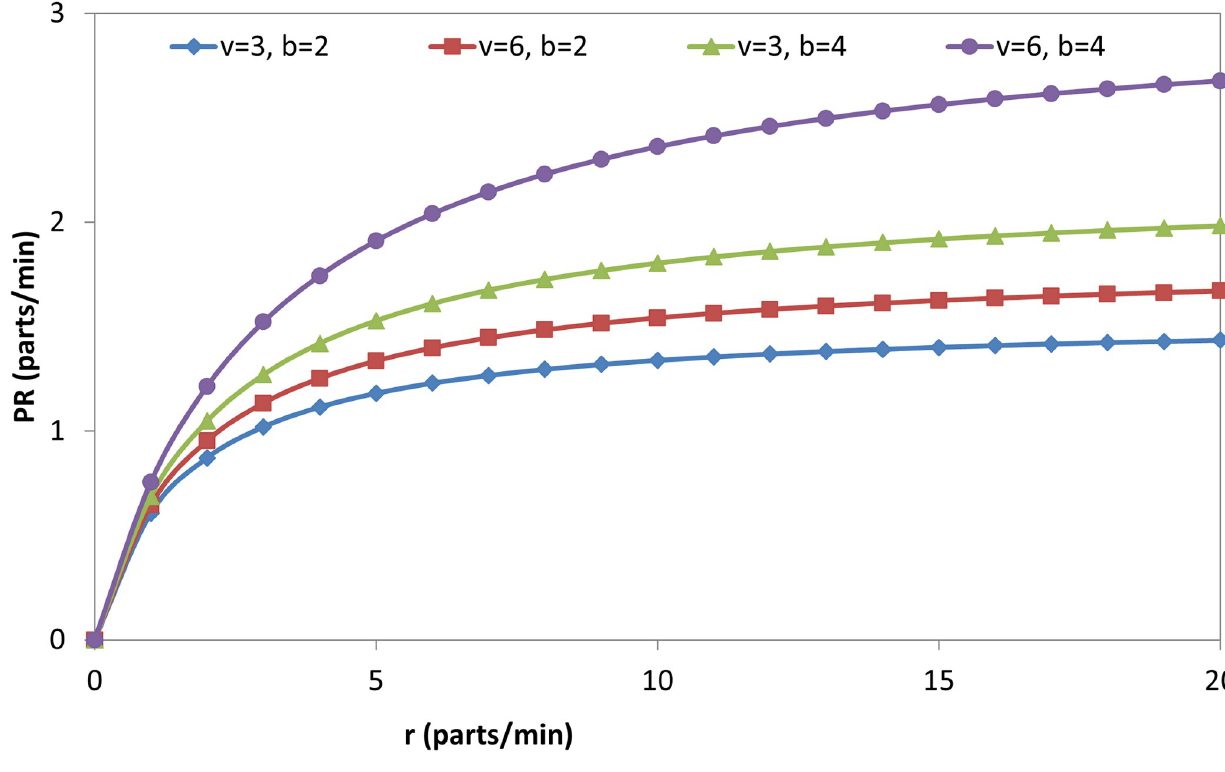
Fig 10. PR-r diagram for single-machine FMC.